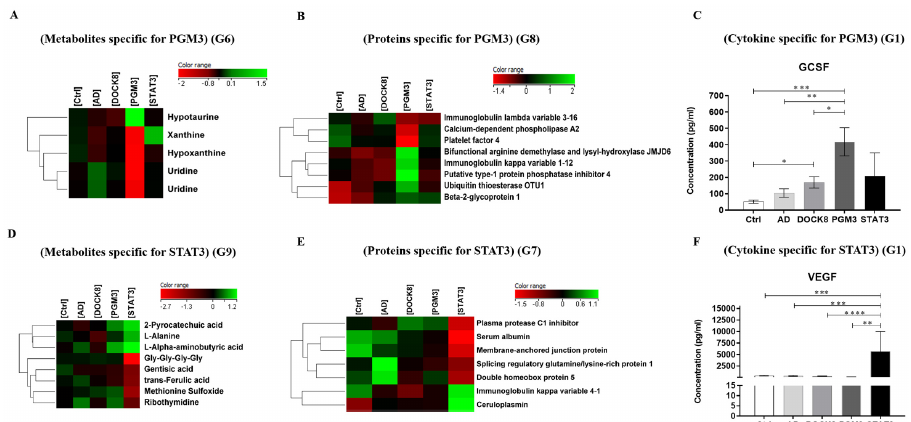
Figure 2. Distinctive Multi-omics profiles for PGM3 and STAT3 deficiencies. Heat maps show specific ( A ) metabolic (n = 6), ( B ) proteins (n = 8), and ( C ) GCSF (Granulocyte-colony stimulating factor) expressions for PGM3 deficiency compared to the other study’s groups. Heat maps show distinctive expression profiles for STAT3 deficiency based on ( D ) metabolomics (n = 8), ( E ) proteomics (n = 7), ( F ) cytokine VEGF (Vascular endothelial growth factor) datasets by entities’ hierarchical clustering for the average normalized data, where the similarity was based on Pearson. Cytokines: Five groups were compared using the One-way ANOVA and Tukey’s tests. * indicates significance. * p <0 .05, ** p < 0.01, *** p < 0.001. Not specified ones are not significant. Abbreviations: Ctrl: Controls, AD: Atopic dermatitis, DOCK8: Dedicator of cytokines8, PGM3: Phosphoglucomutase, 3 STAT3: Signal Transducer Activator of Transcription